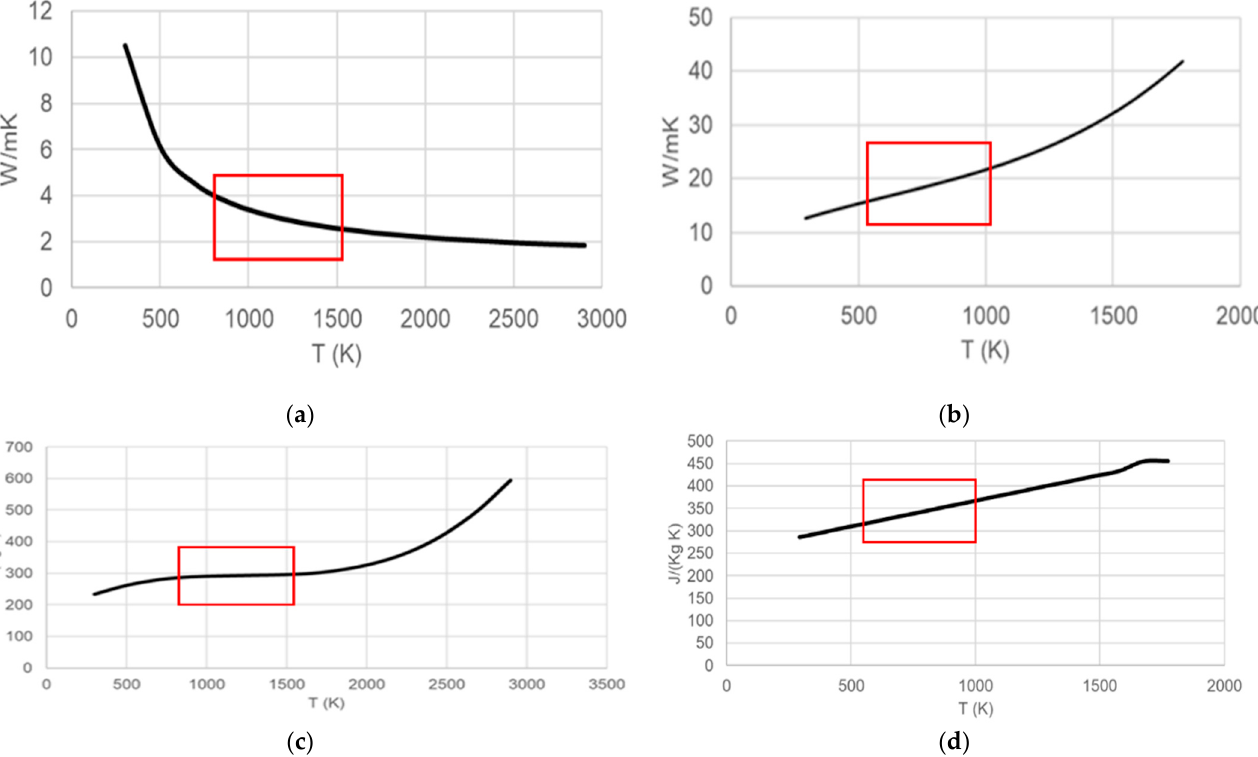
Figure 22. Thermal properties: ( a ) fuel thermal conductivity; ( b ) cladding thermal conductivity; ( c ) fuel thermal capacity; ( d ) cladding thermal capacity [19].